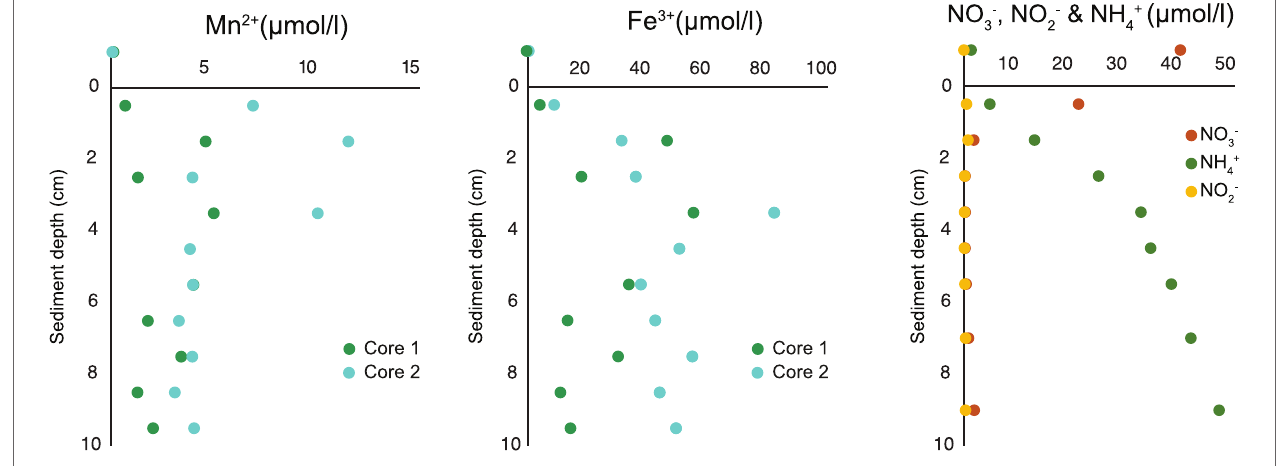
TABLE 2 | Average (±SD) intracellular nitrate content per foraminiferal cell and denitrification rates for all tested species. Species Nitrate + nitrite pool Denitrification rate (pmol/indiv) (pmol/ind/day)